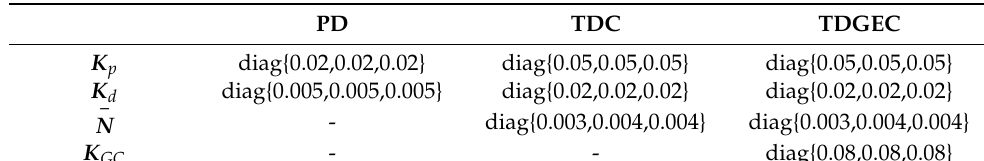
Table 4. Parameter setting of three controllers.